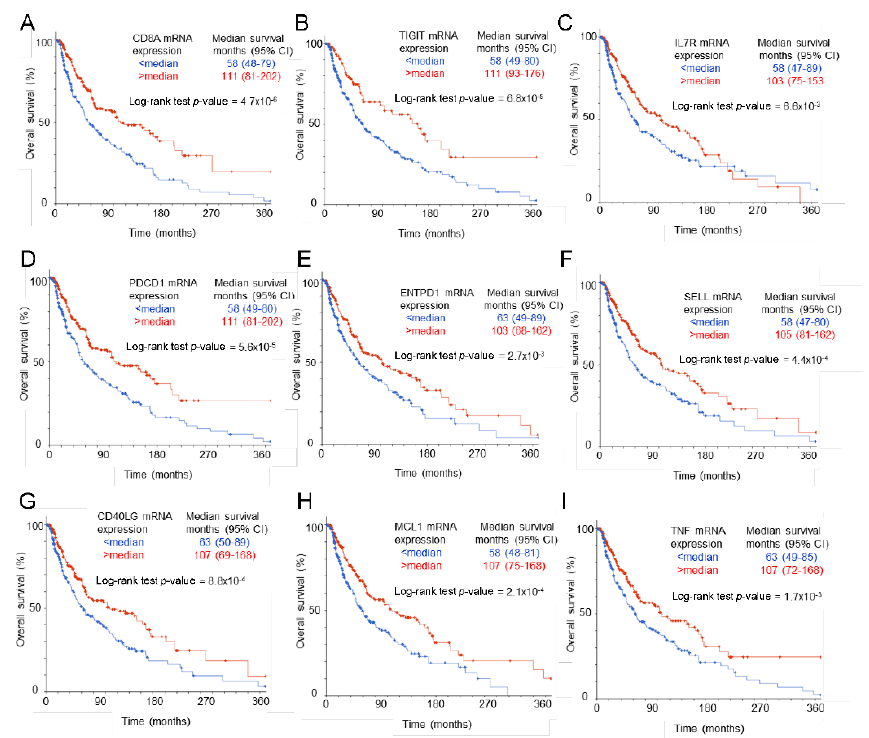
Figure 4. Association of CD8 T cell marker and CD47-dependent regulators of T cell function with overall survival in human melanomas. Kaplan–Meier plots for overall survival of 469 TCGA cutaneous melanoma patients with higher versus lower CD8 T cell infiltration indicated by CD8A mRNA expression greater than or less than the median ( A ) or with mRNA expression greater than or less than the median of the CD47-dependent genes TIGIT ( B ), IL7R ( C ), PDCD1 (PD-1, D ), ENTPD1 (CD39, E ) SELL (CD62L, F ), CD40LG ( G ), MCL1 ( H ), and TNF ( I ). The median survival of each group is presented with the respective 95% confidence intervals. Table 1. Coexpression of CD8 T cell markers and T cell regulatory genes with CD47, MYCN, and MYC mRNAs in TCGA skin cutaneous melanomas with RNA Seq V2 RSEM data was analyzed using cBioPortal tools ( n = 472).